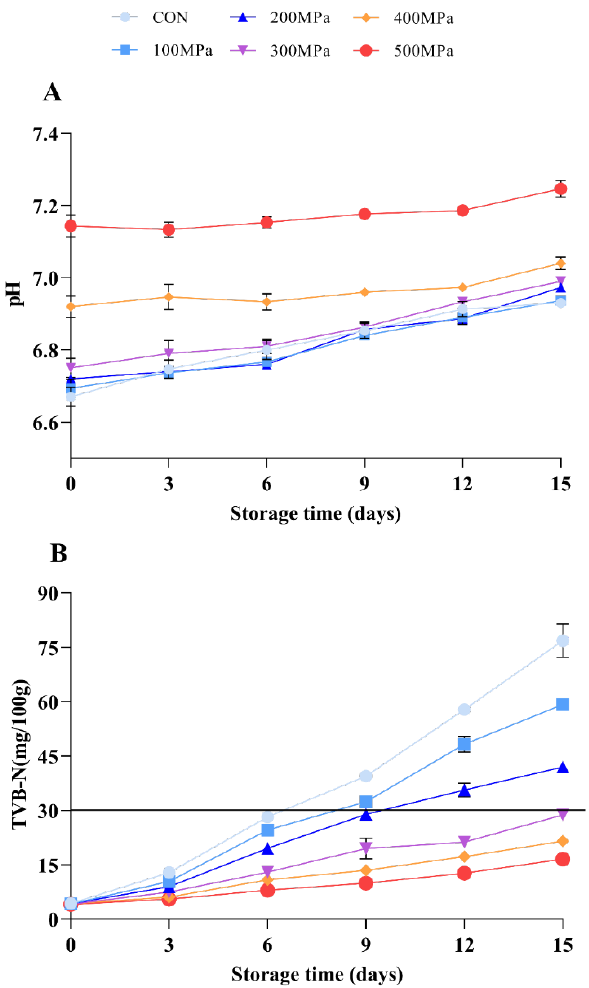
Figure 5. Effects of UHP treatment on the ( A ) pH and ( B ) TVB-N of shrimp during storage. Solid-line represents 30 mg/100 g of TVB-N, the national standard limit for fresh aquatic products.